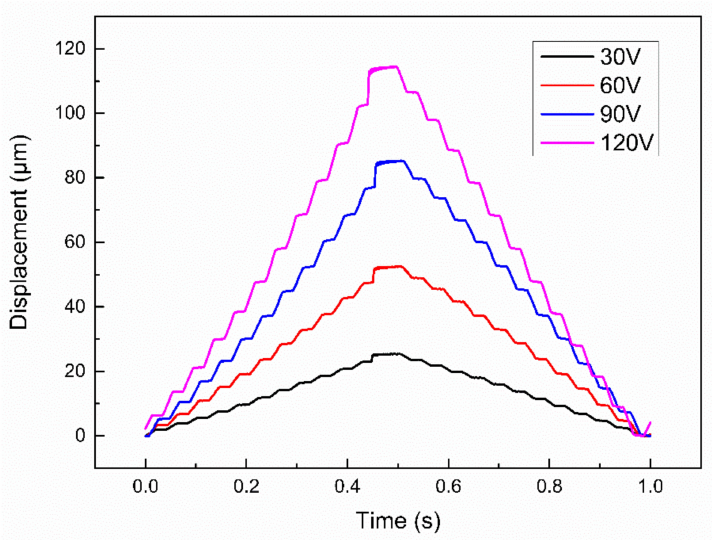
Figure 21. Step displacement of the mechanism when the input voltage is 30 V, 60 V, 90 V, and 120 V.